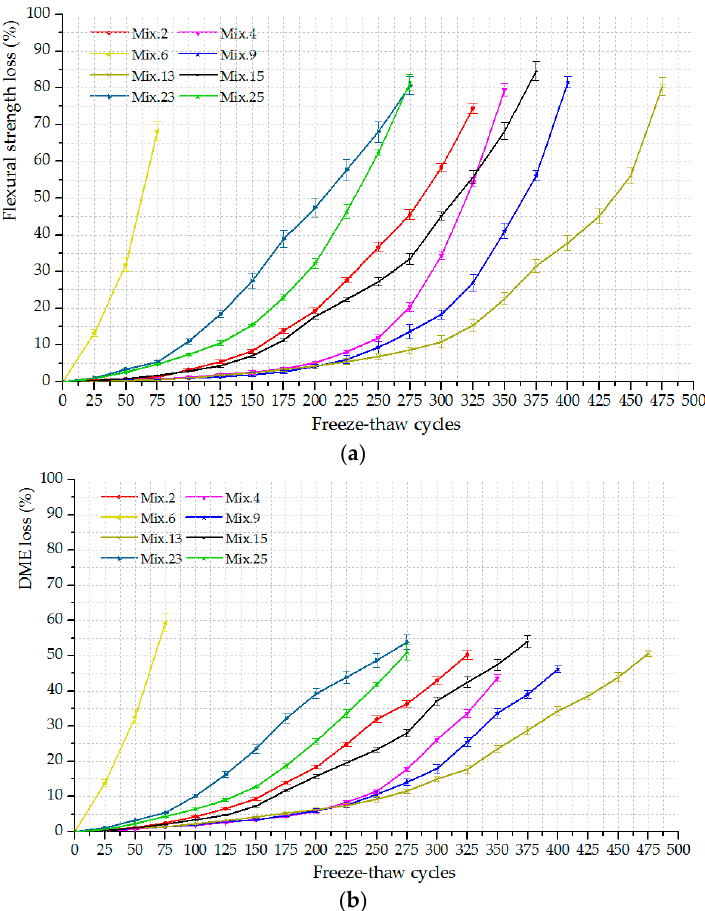
Figure 8. The engineering property loss of typical ECC mixtures versus freeze-thaw cycles (L-C curves): ( a ) The loss in flexural strength; ( b ) The loss in DME.